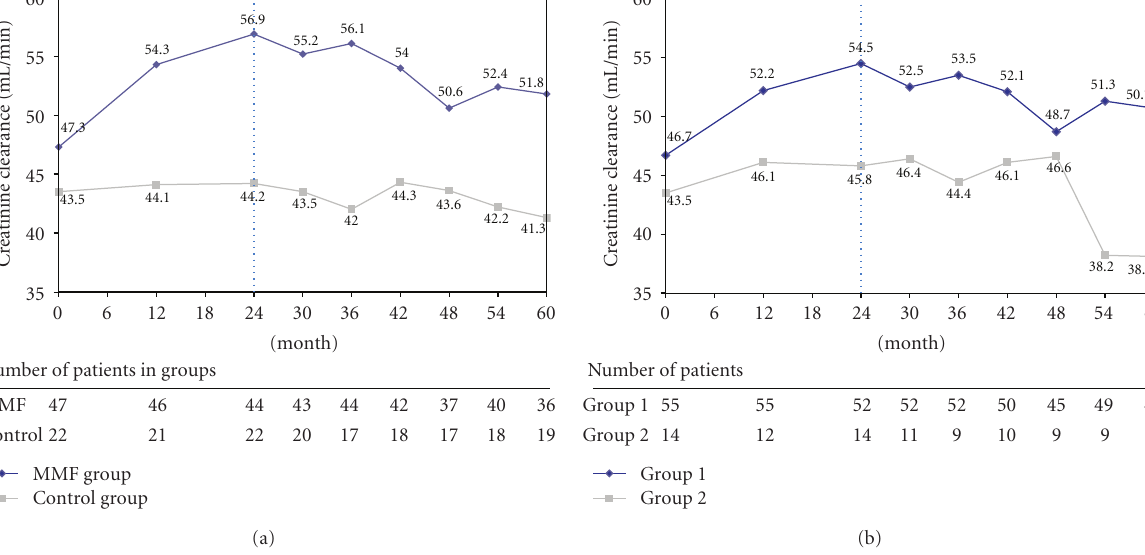
Figure 4: (a). Evolution of creatinine clearance over time in the randomization population (MMF group versus control group). (b) Evolution of creatinine clearance over time in the on-treatment population (group I versus group II). The vertical, dotted line separates initial study phase and follow up